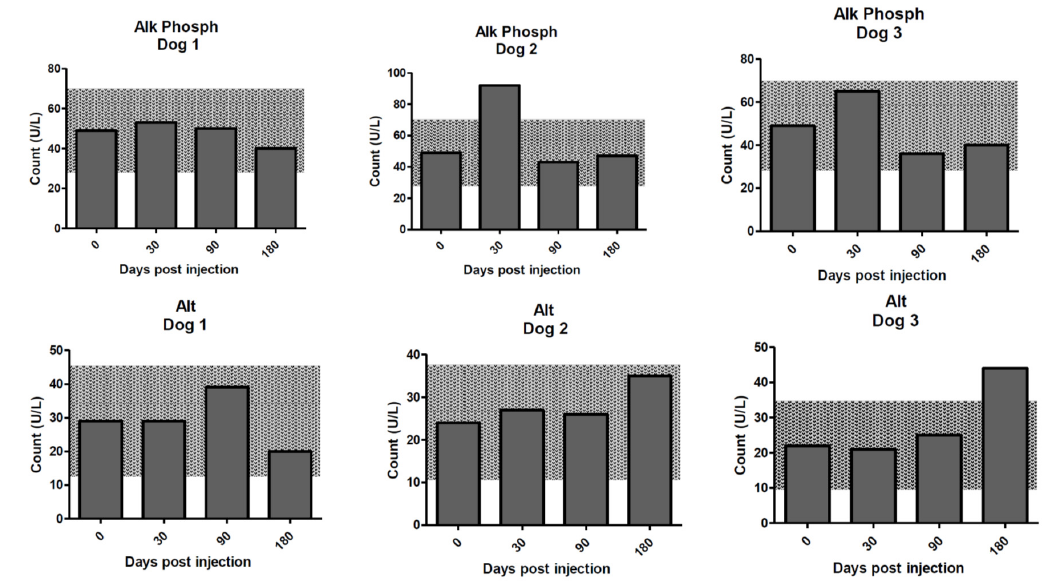
Figure 6. Liver enzyme measurements for the dogs on days 0–180 post treatment with 213 Bi-400-2 antibody. Upper row—alkaline phosphatase; lower row—alanine aminotransferase. Shaded areas show reference change values (RCVs).